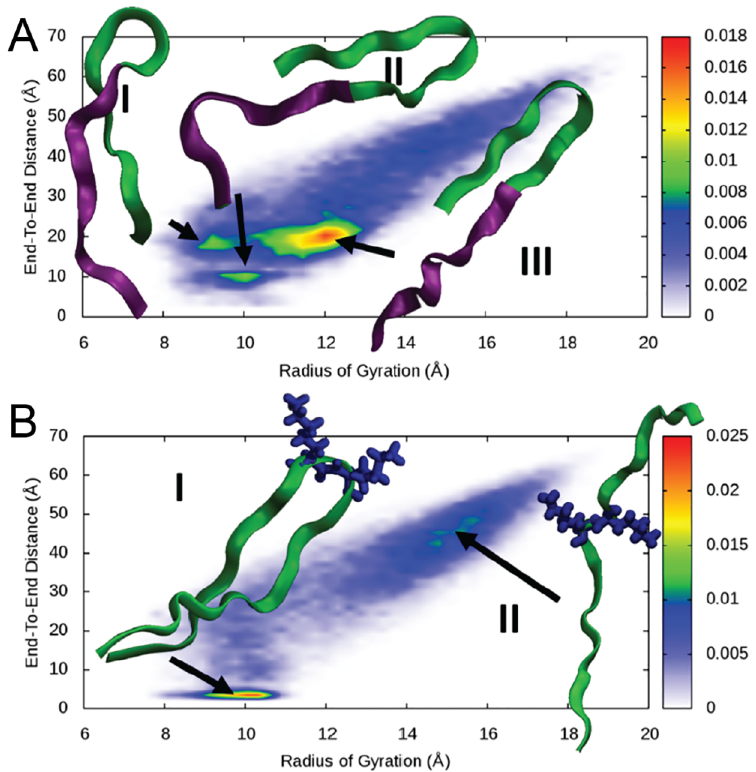
Fig 2. Normalized distribution of the end-to-end and radius of gyration plot for PEP-1 (A) and PEP-2 (B). PEP-1 populates three major clusters characterized by β -hairpinconformations. The N-terminus (RVFKRYKRW, labelledin purple)is usuallyfully exposedto the solvent. PEP-2 conformations are dominated by the repulsionof the two central lysines. The most stable conformations are characterized by the two lysines pointingin oppositedirection(side chains reportedin blue) in order to minimizetheir